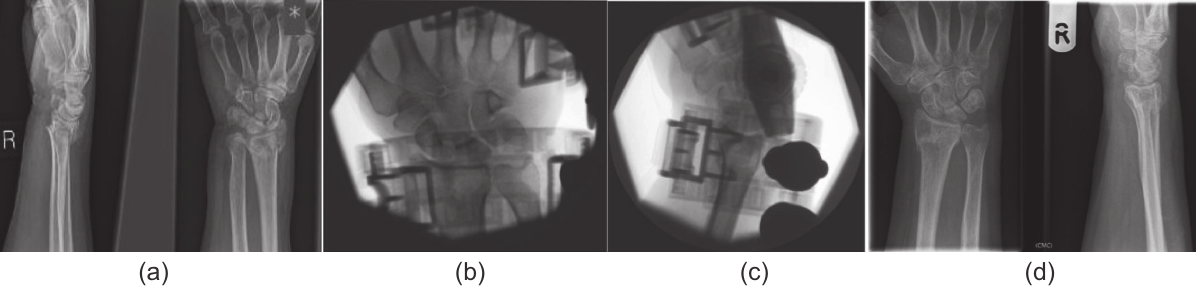
Figure 2. Radiographs and fluoroscopic images of a 65-year-old patient with unstable extra-articular DRF (a) treated with non-invasive dynamic external fixator (b and c). There was no collapse or shortening at the fracture at six-month post-op radiographs